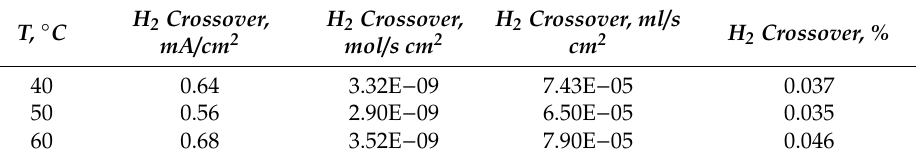
Table 2. Electro-chemical H 2 crossover of FAA3-50-based MEA.